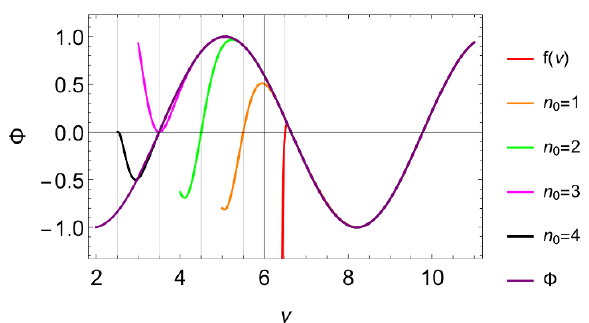
Figure 2 . We show one mode of e (cid:8) as a function of (cid:23) (violet) and the regularized expression of R K(cid:30) given by (3.11) for n 0 = 1 ; 2 ; 3 ; 4 and d = 15. The gray vertical lines depict the place where the domain of each curve ends. It is evident that with each additional regulating term, the kernel K can be extended one negative unit in (cid:23) . The graphs are truncated because we are using a non-zero regulator (cid:15) = 0 :